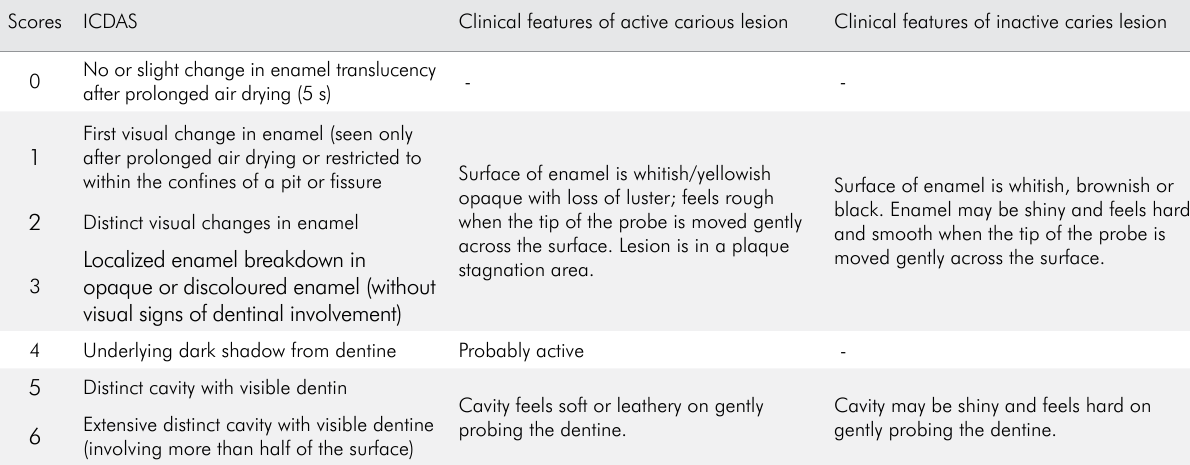
Table 1. International Caries Detection and Assessment System (ICDAS) 5 and additional criteria used in the caries activity assessment. 19,20,21